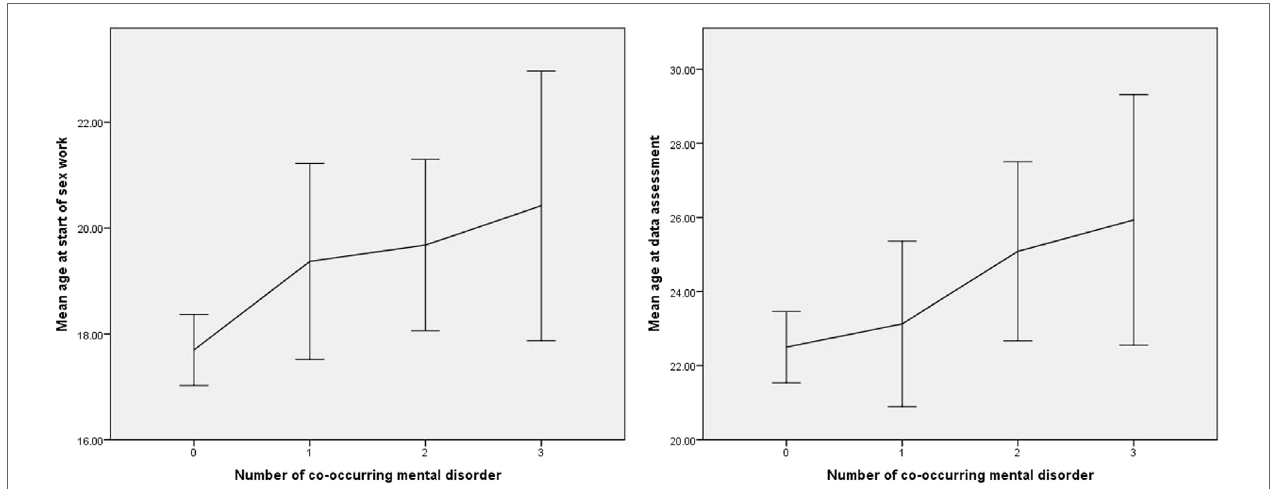
FigUre 3 | association of age with number of co-occurring mental disorders (error bars indicate 95% confidence intervals)